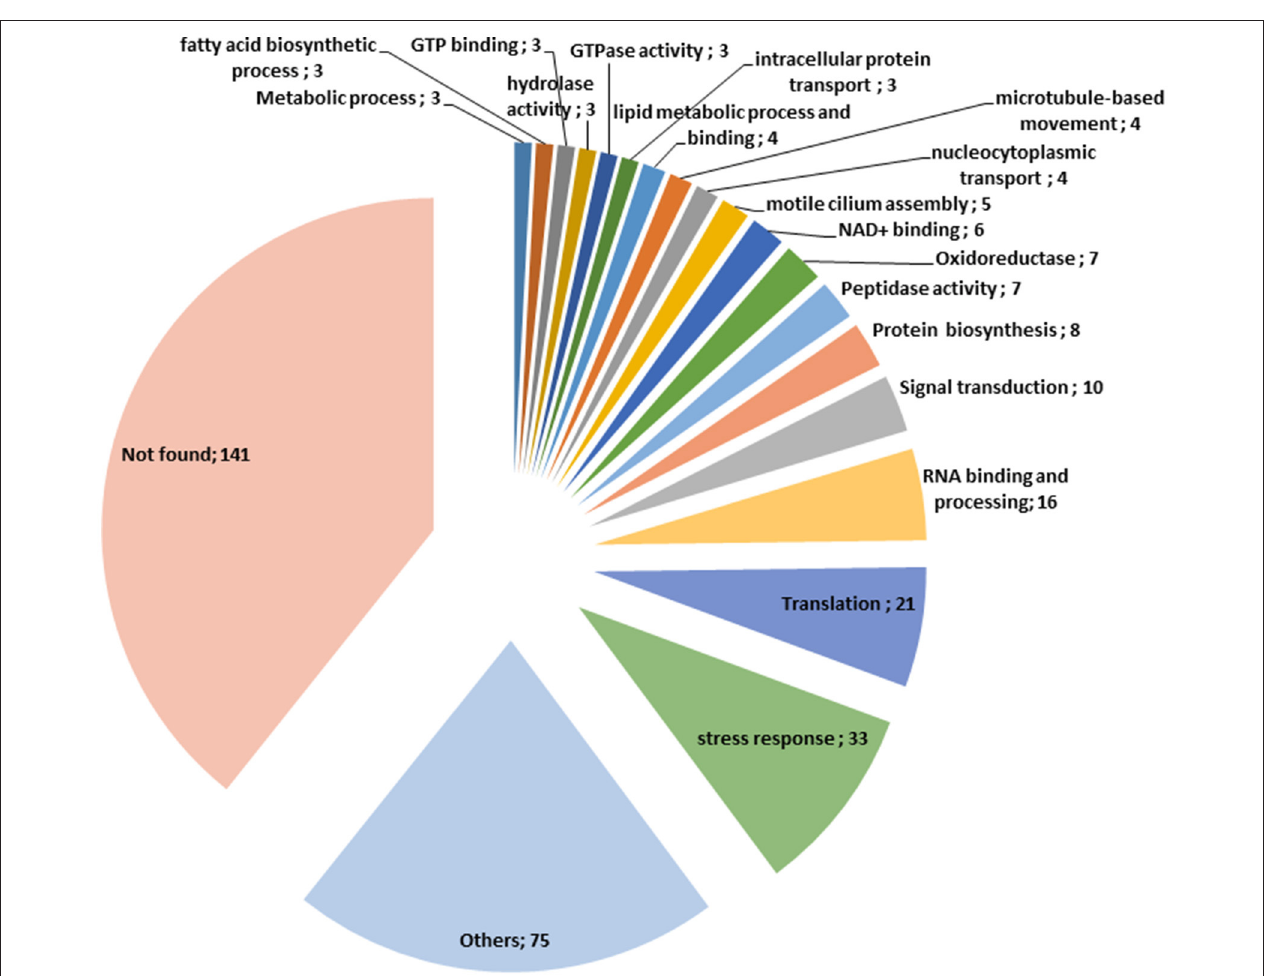
FIGURE 5 | Classification of the O -GlcNAcylated proteins found in this study according to their function.